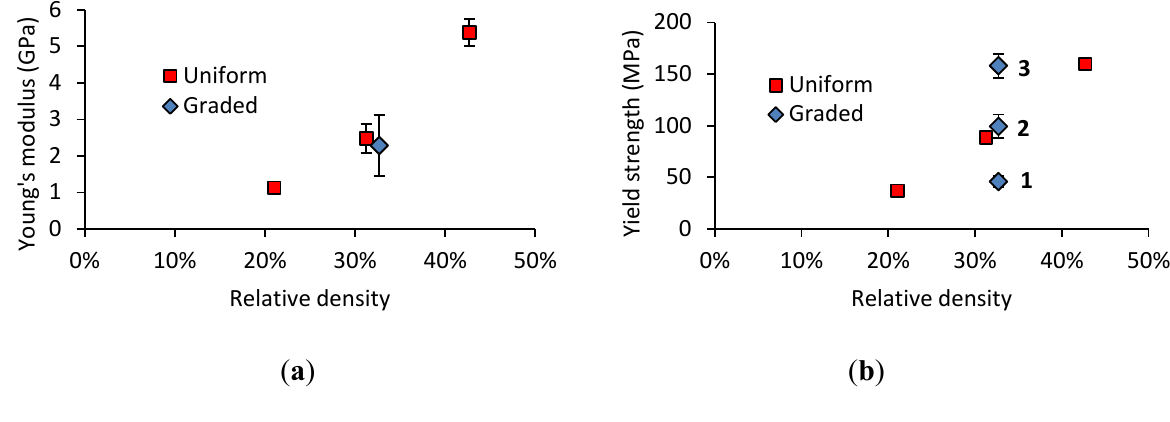
Figure 3. Comparison of the mechanical properties of the graded and uniform lattices against relative density: ( a ) Young’s modulus, ( b ) yield strength. The values of the three stress peaks (corresponding to collapse of each of the layers in sequence) are shown for the graded lattice, as this shows the correlation in values with the stresses associated with the first peak in the uniform lattice